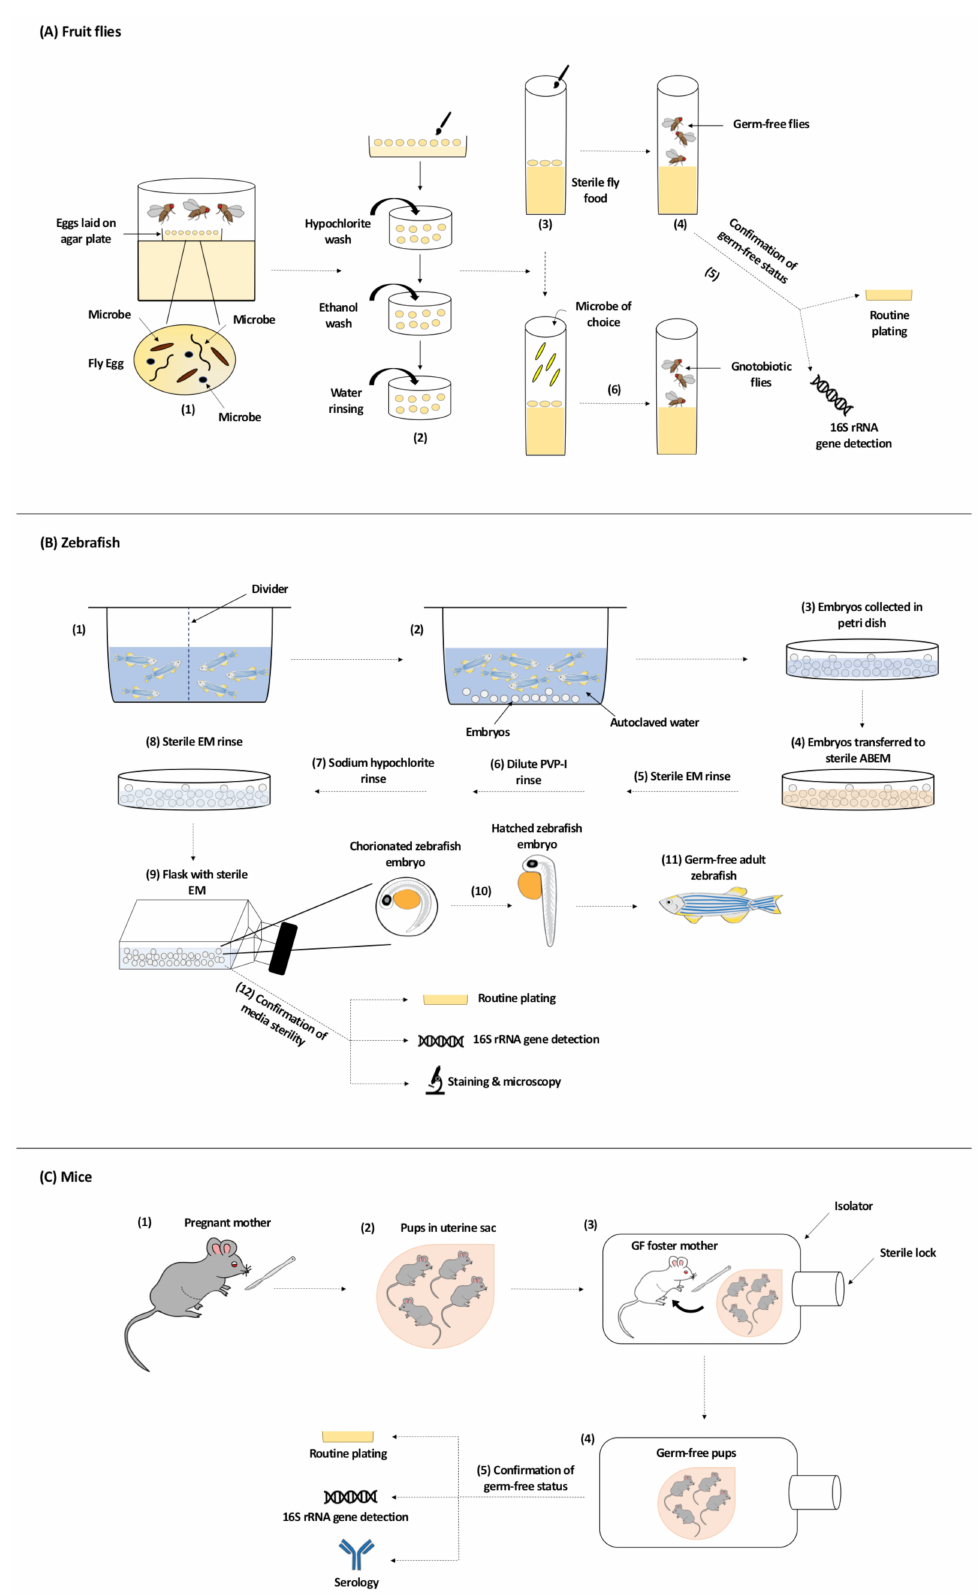
Figure 2. Generation of Germ-Free Model Organisms. ( A ) Generation of Germ-Free Fruit Flies. Fliestrappedinacagelaytheireggsontheagarplate. Thesurfaceofthelaideggsharborsmicroorganisms from maternal fecal deposits (1). Using a sterile paint brush, eggs are collected from the agar plate before larval formation, dechorionated with hypochlorite solution, and rinsed with water. An ethanol